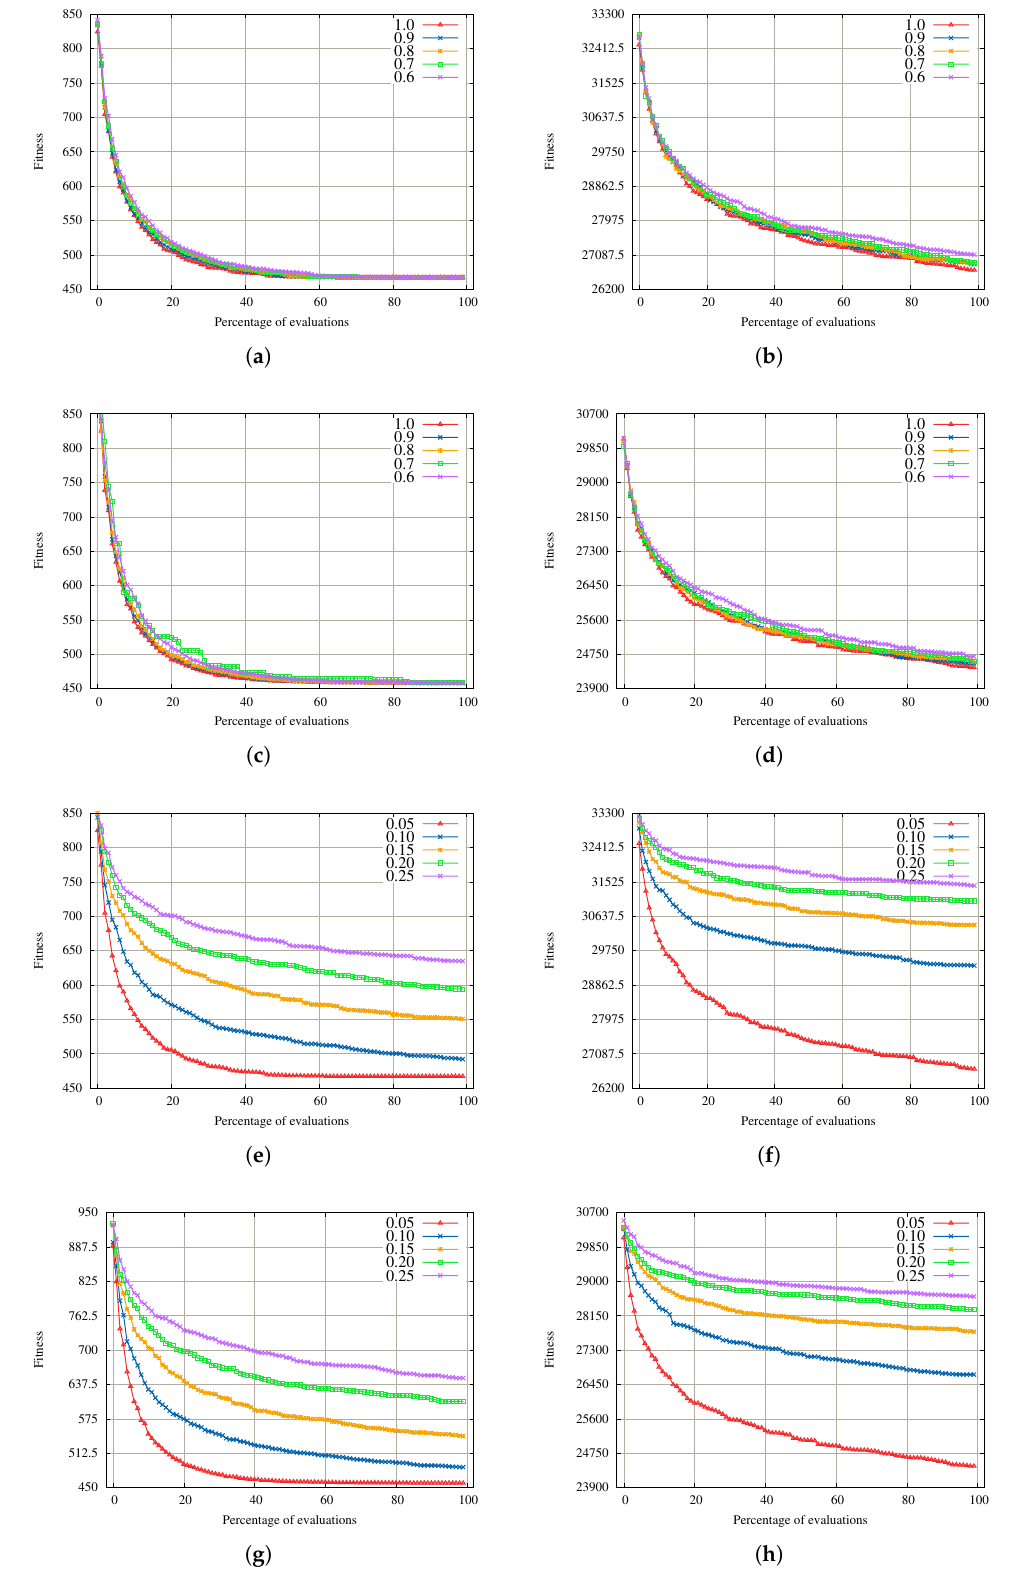
Figure 7. Crossover and mutation rates fitness evolution for the CGA. ( a ) Instance Small 1 crossover rates. ( b ) Instance Large 1 crossover rates. ( c ) Instance Small 2 crossover rates. ( d ) Instance Large 5 crossover rates. ( e ) Instance Small 1 mutation rates. ( f ) Instance Large 1 mutation rates. ( g ) Instance Small 2 mutation rates. ( h ) Instance Large 5 mutation